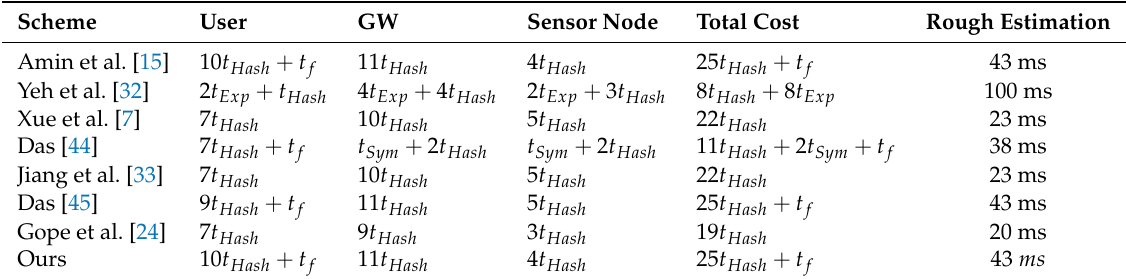
Table 4. Overall computational overhead of the authentication phase.